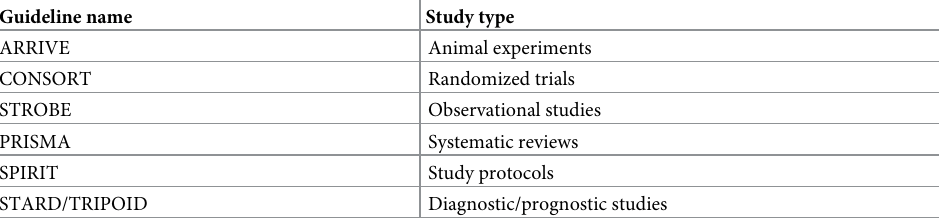
Table 2. Examples of reporting guidelines for different study